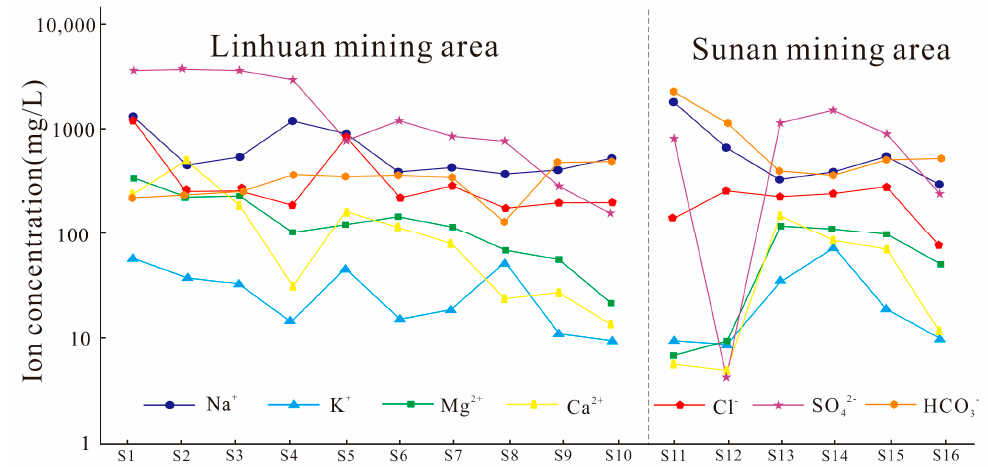
Figure 2. Variation characteristics of various indicators of the Taiyuan formation limestone water in the study area.